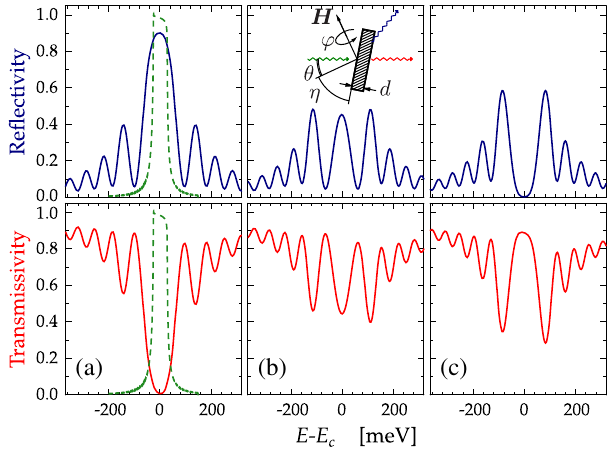
FIG. 6. Reflection (blue) and transmission (red) spectral pro- files of x-rays in a diamond beam-splitter crystal S 1 set to the H ¼ ð 111 Þ Bragg diffraction in Laue-case geometry with η ¼ 54 . 74 ° [the entrance crystal surface is parallel to the (100) planes]. The profiles are calculated for the crystal thickness d varying with an increment of Λ H = 4 of the Pendelösung period Λ H ¼ 11 μ m: (a) d ¼ 27 . 6 μ m; (b) d ¼ 30 . 4 μ m; and (c) d ¼ 33 . 2 μ m. The spectral profiles and the cavity reflection profile (dashed green line) are centered at the same energy E c ¼ 6 . 9558 keV. The x- rays are at the incidence angle θ ¼ 25 . 6434 ° to the diffraction planes (111) and at 88° to the (400) planes in the cavity crystals. ≃ 90% reflectivity at E ¼ E in Fig. 6(a), while the picture c reverses in Fig. 6(c). The Pendellösung period is equal to ¯ Λ Λ ¼ 2 π ¯ Λ H H , where H is the extinction length given by Eq. (1). In particular, for the case of the beam-splitter